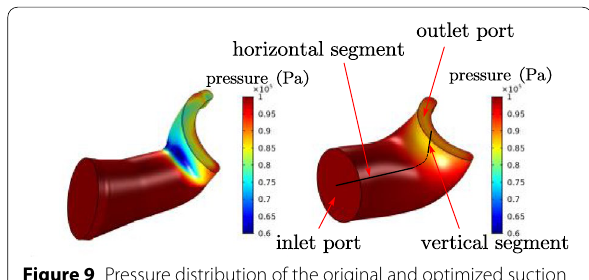
Figure 9 Pressure distribution of the original and optimized suction